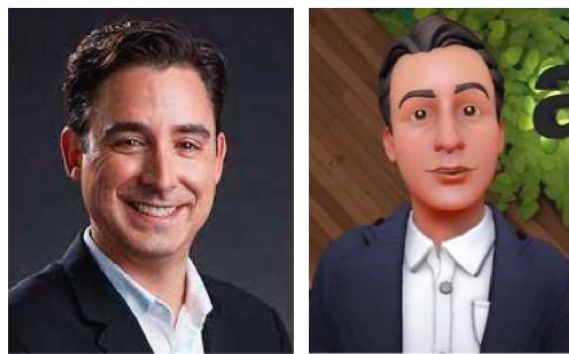
Figure 7: Representation of a virtual character in Microsoft Mesh as demonstrated by the team during Microsoft Ignite Fall Edition 2021. It presents how every person can curate their personal character and use it during meetings and conferences to add a personal touch.